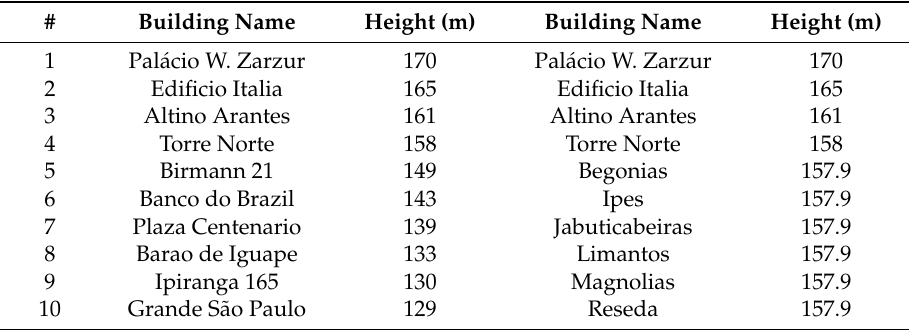
Figure 19. São Paulo in 2000 and 2020. Figure 19. S ã o Paulo in 2000 and 2020. Table 29. S ã o Paulo’s 10 tallest skyscrapers in 2000 and Table 29. São Paulo’s 10 tallest skyscrapers in 2000 and 2020.